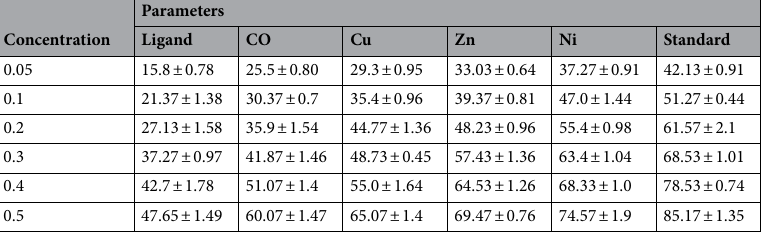
Table 4. The effect of the ligand and its complexes on the antioxidant nitric acid (NO) at different concentrations (0.05–0. 5 mg/mL).